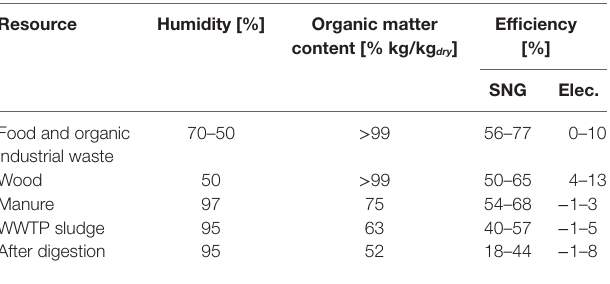
TaBle 1 | Performances for the hydrothermal gasification with dry matter content of 20% (Gassner et al., 2011).